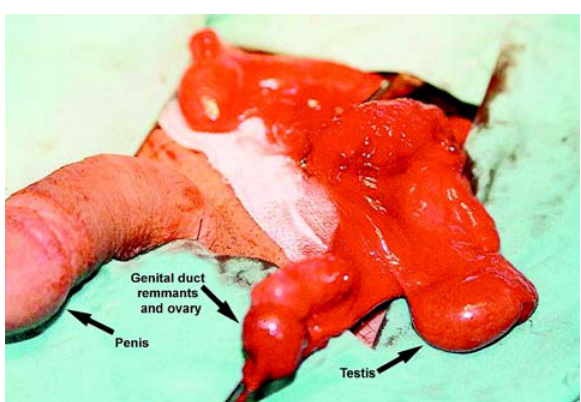
Figure 1 – Intraoperative view of the female genital duct remnants, ovary and